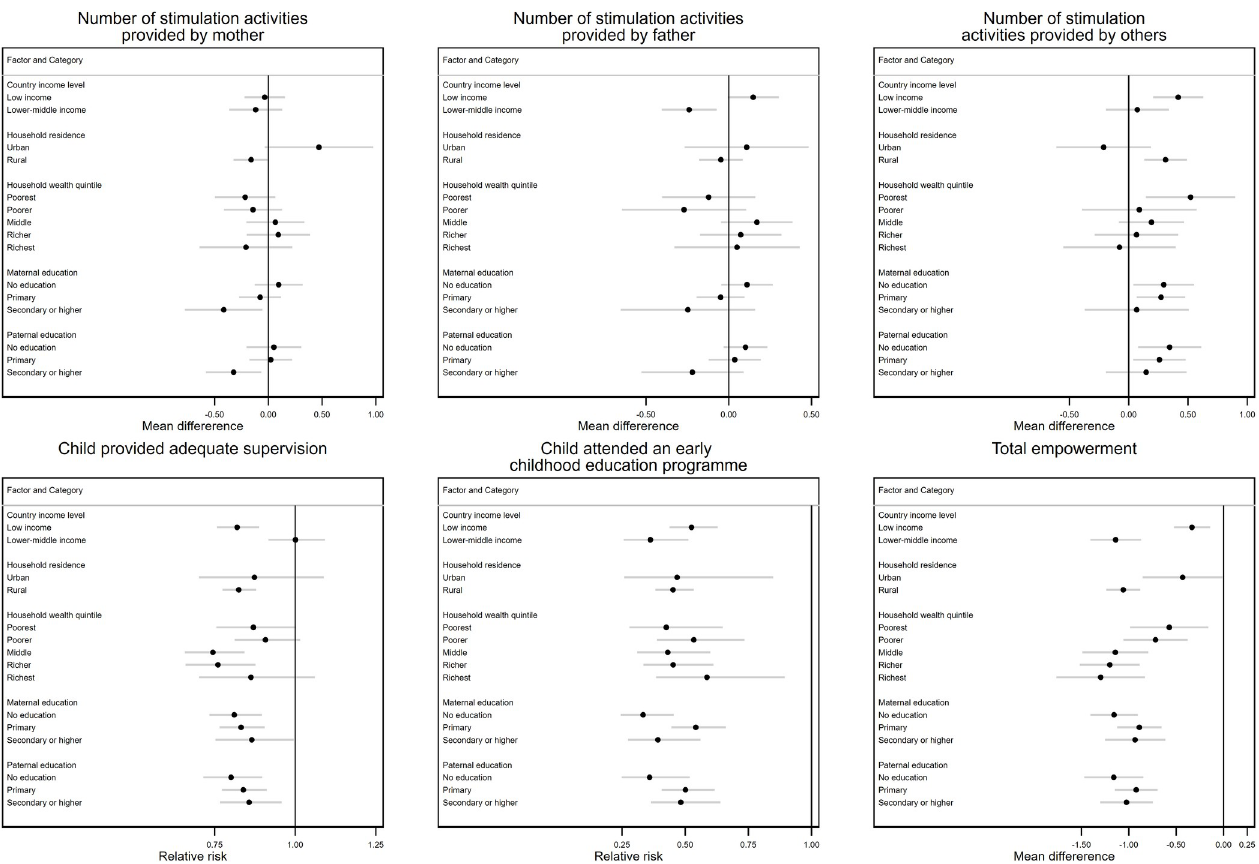
Fig 2. Heterogeneity of the associations between parental occupation, childcare practices, and women’s empowerment by household and parental characteristics, comparing households where both parents were employed in agriculture and households where both parents were employed in non- agriculture. Models adjusted for child age and sex, maternal age and education, paternal age and education, household size, wealth, and location (urban vs. rural), and accounted for representativeness. SEs were clustered at the primary sapling unit level.